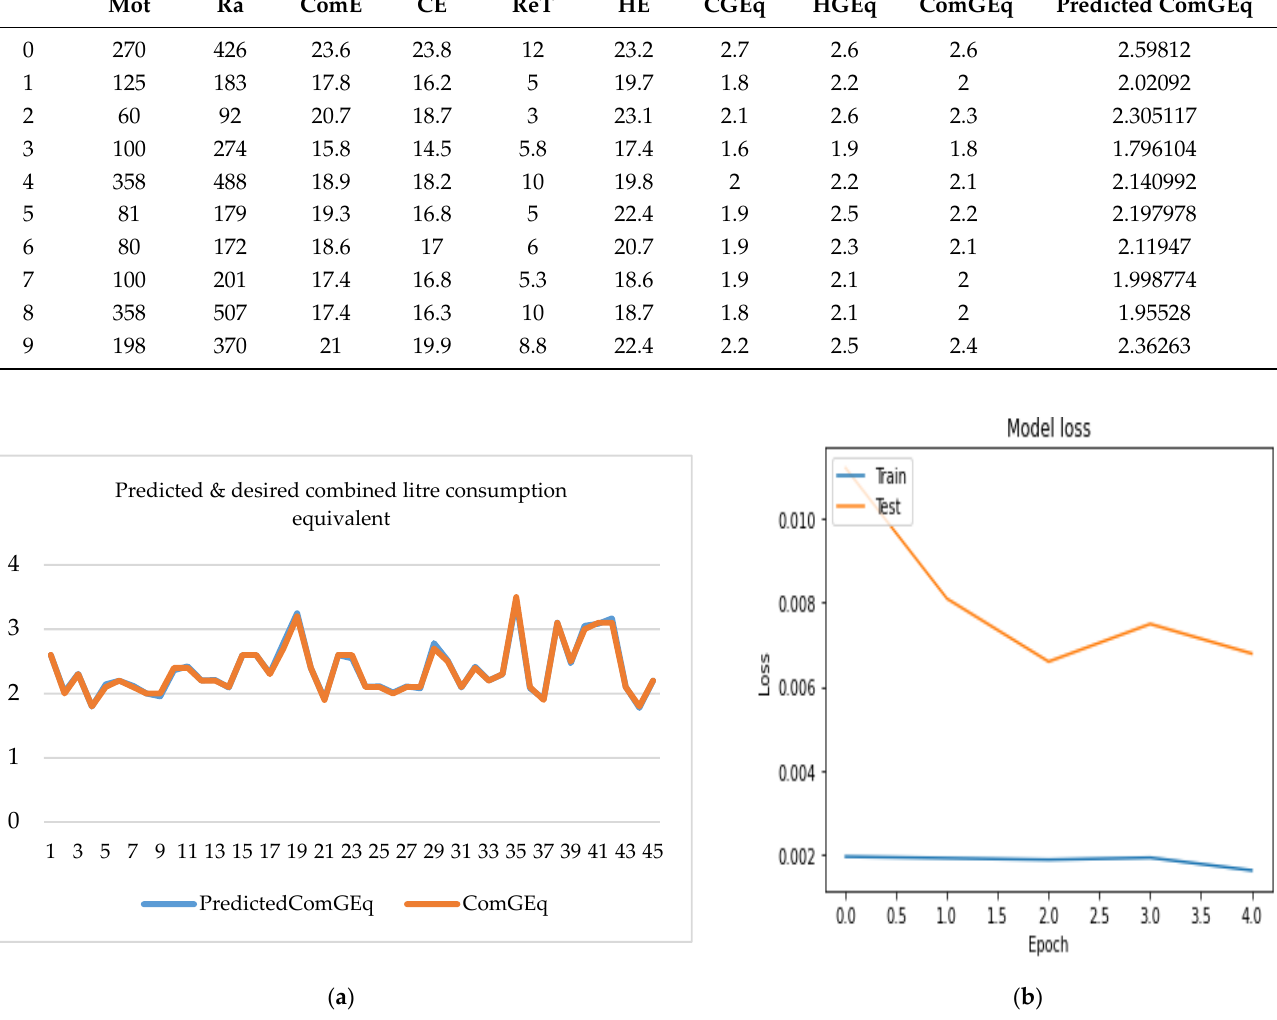
Table 9. Predicted and desired electrical motor power.